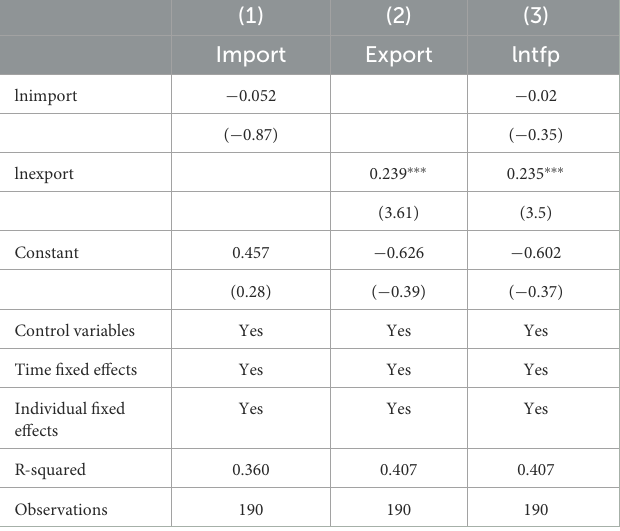
TABLE 7 Estimation results of the effects of agricultural imports and exports on